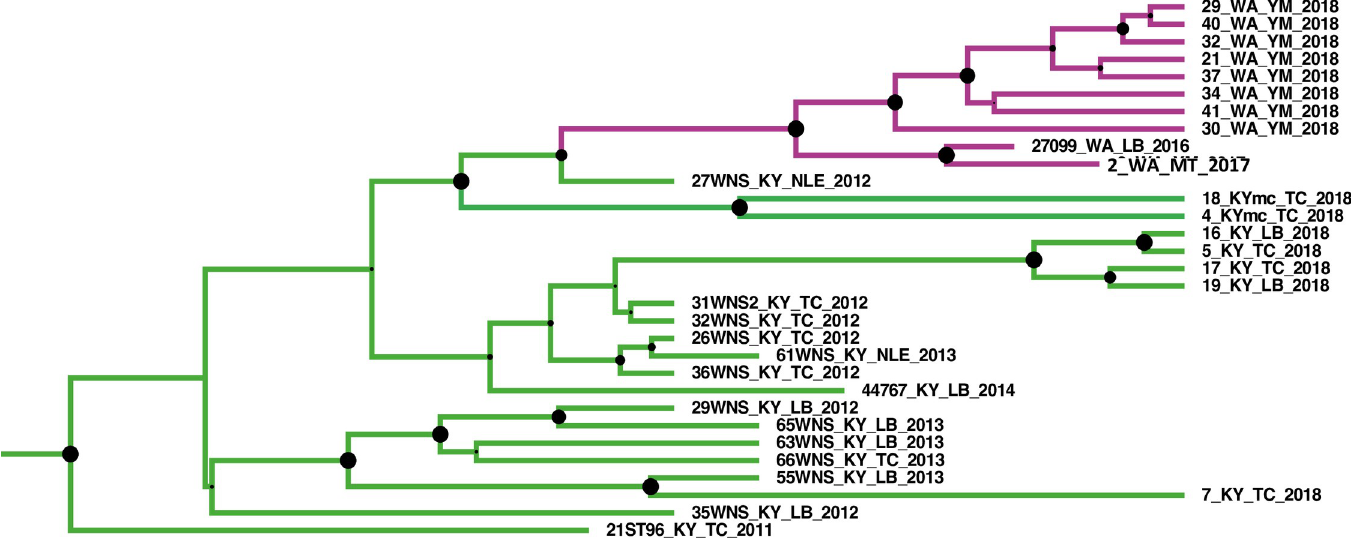
Fig 4. Zoom-in view of the Kentucky-Washington clade from the summary maximum clade credibility (MCC) tree in Fig 1. The 27WNS_KY_NLE_2012 isolate from Kentucky is phylogenetically close to the isolates sampled from Washington. All these isolates along with Mammoth cave isolates (18KYmc_TC_2018 and 4KYmc_TC_2018) shared a common ancestor. The number close to each node corresponds to the posterior support value which is also graphically represented by the size of the solid black circle in each node.